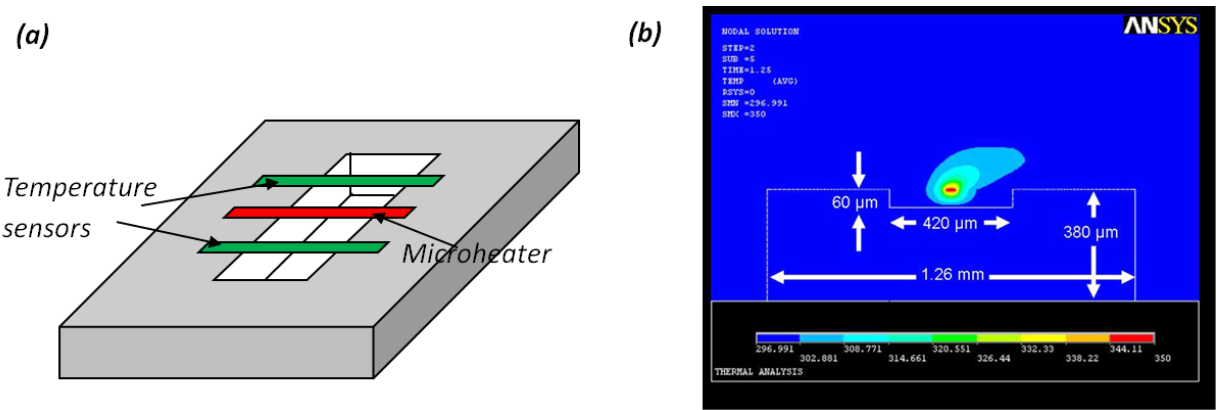
Figure 12. Thermal convection based accelerometer. (a) the typical configuration; and (b) an external acceleration induces temperature field asymmetry around the microheater.